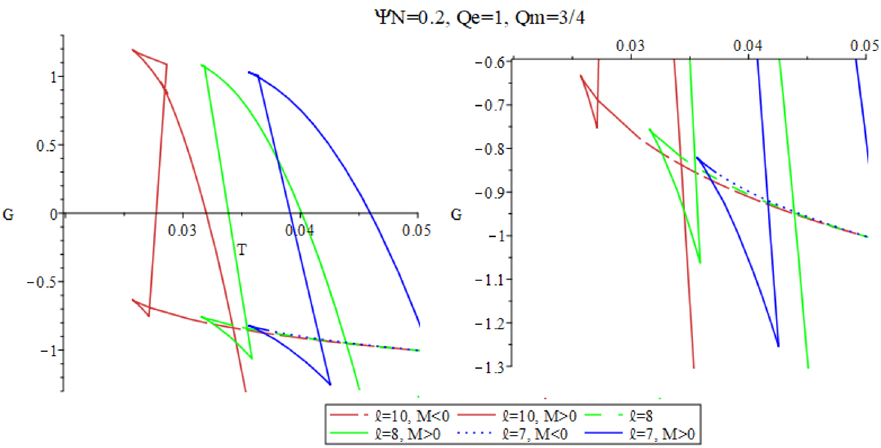
Figure 16 . Inverted Swallowtails. These structures can appear for cases Ib and IIb; we illustrate them here for Qe = 1 and Q m = 0 . 75 (case Ib). At large pressures there is a lower swallowtail on what would otherwise be a cusp. For sufficiently large ‘ , the upper cusp is replaced with a swallowtail. As ‘ increases (or as pressure decreases) the lower swallowtail shrinks and the upper one grows. Note that the lower parts of each curve have segments where M < 0 . The insets provide close-ups of the upper and lower parts of the